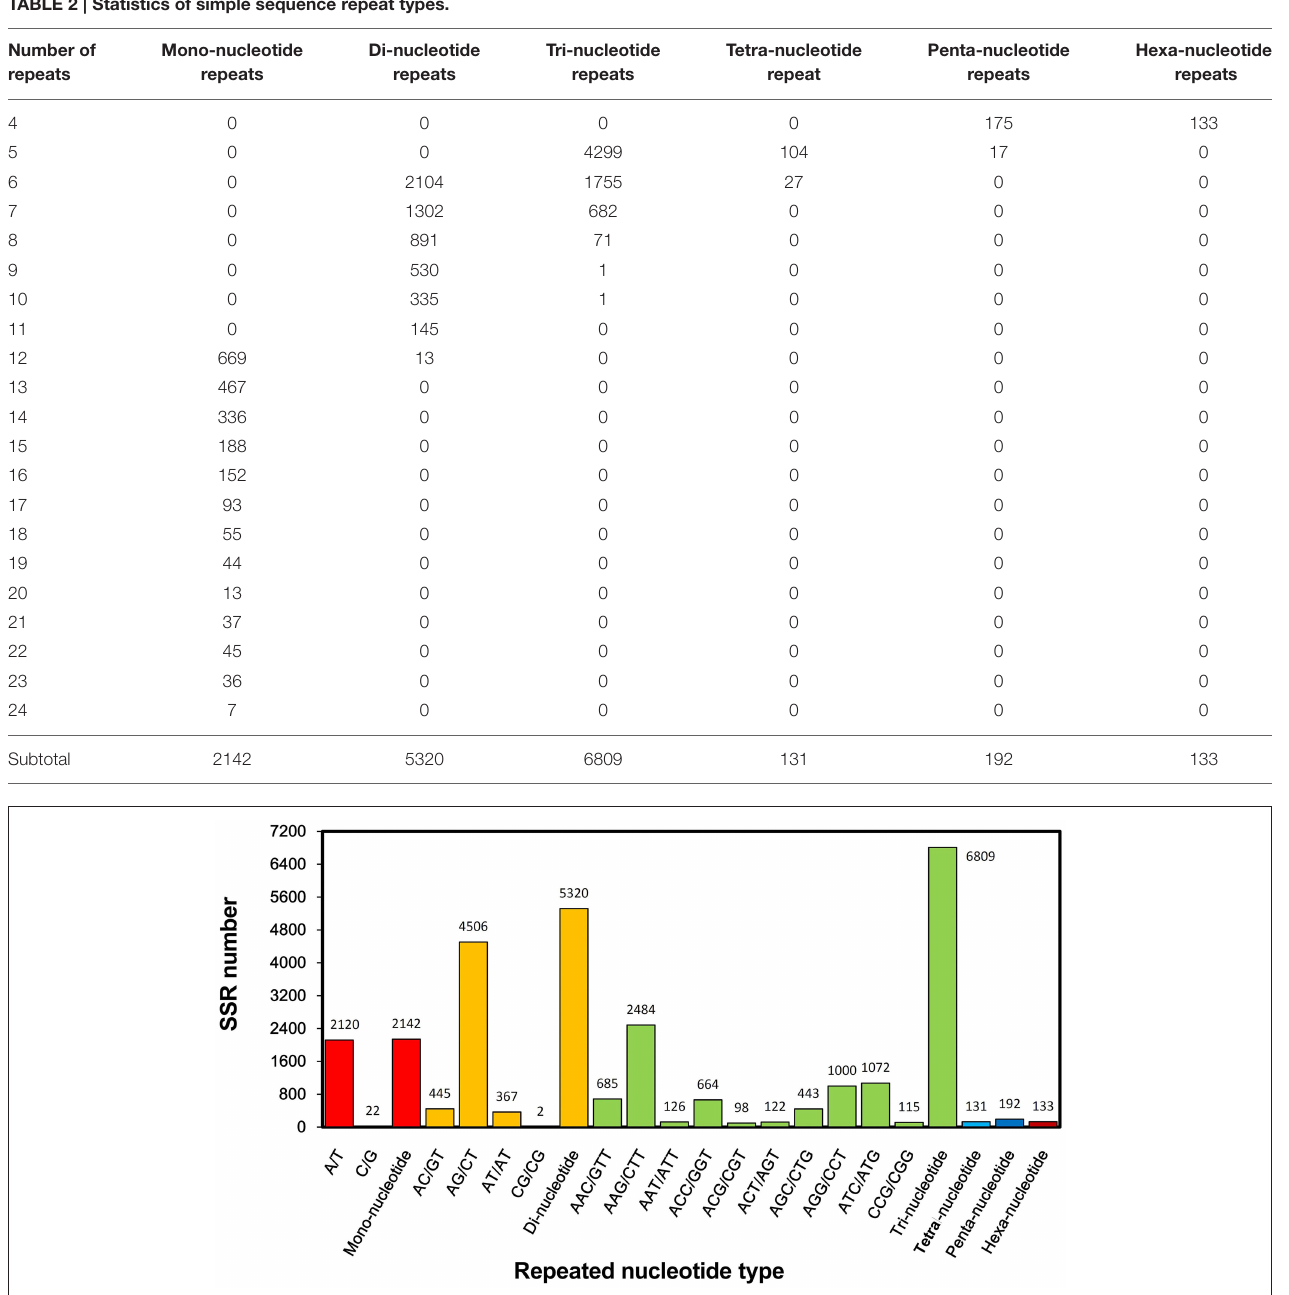
FIGURE 7 | Histogram of the statistics of simple sequence repeat (SSR)